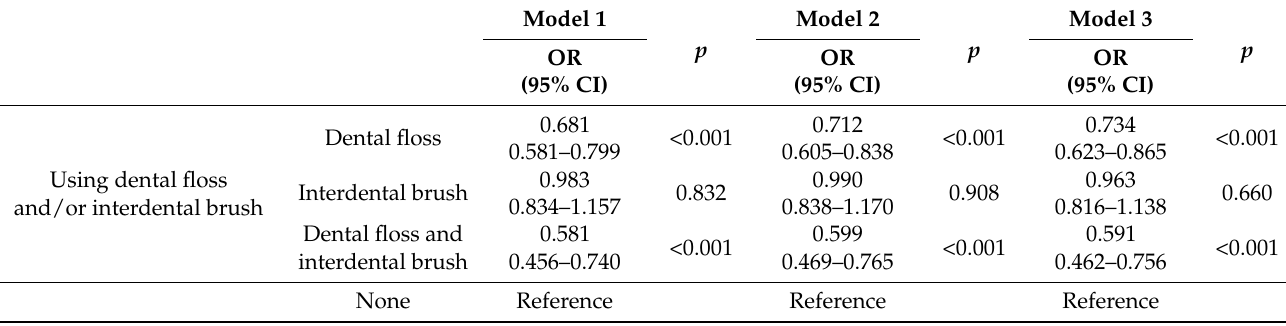
Table 3. Multivariable association between using dental floss and/or interdental brush and high CPI (CPI 3-4).